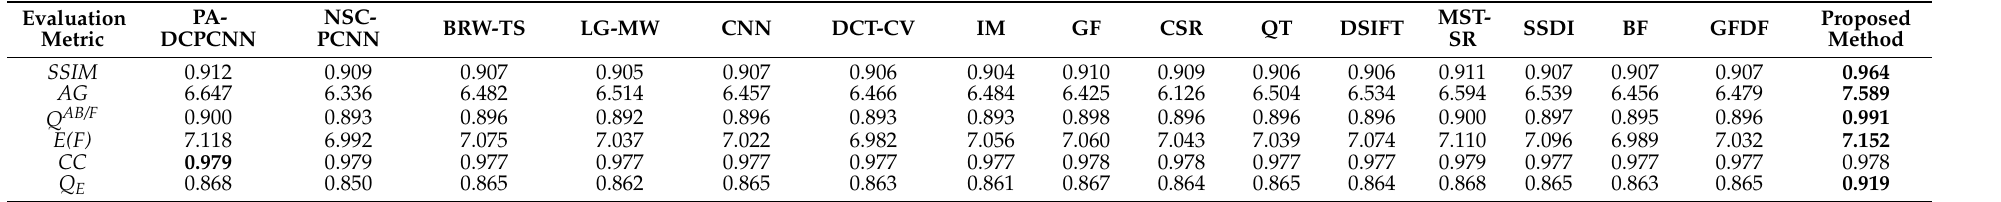
Table 24. The outcomes for the lab image and comparisons with existing techniques in the literature